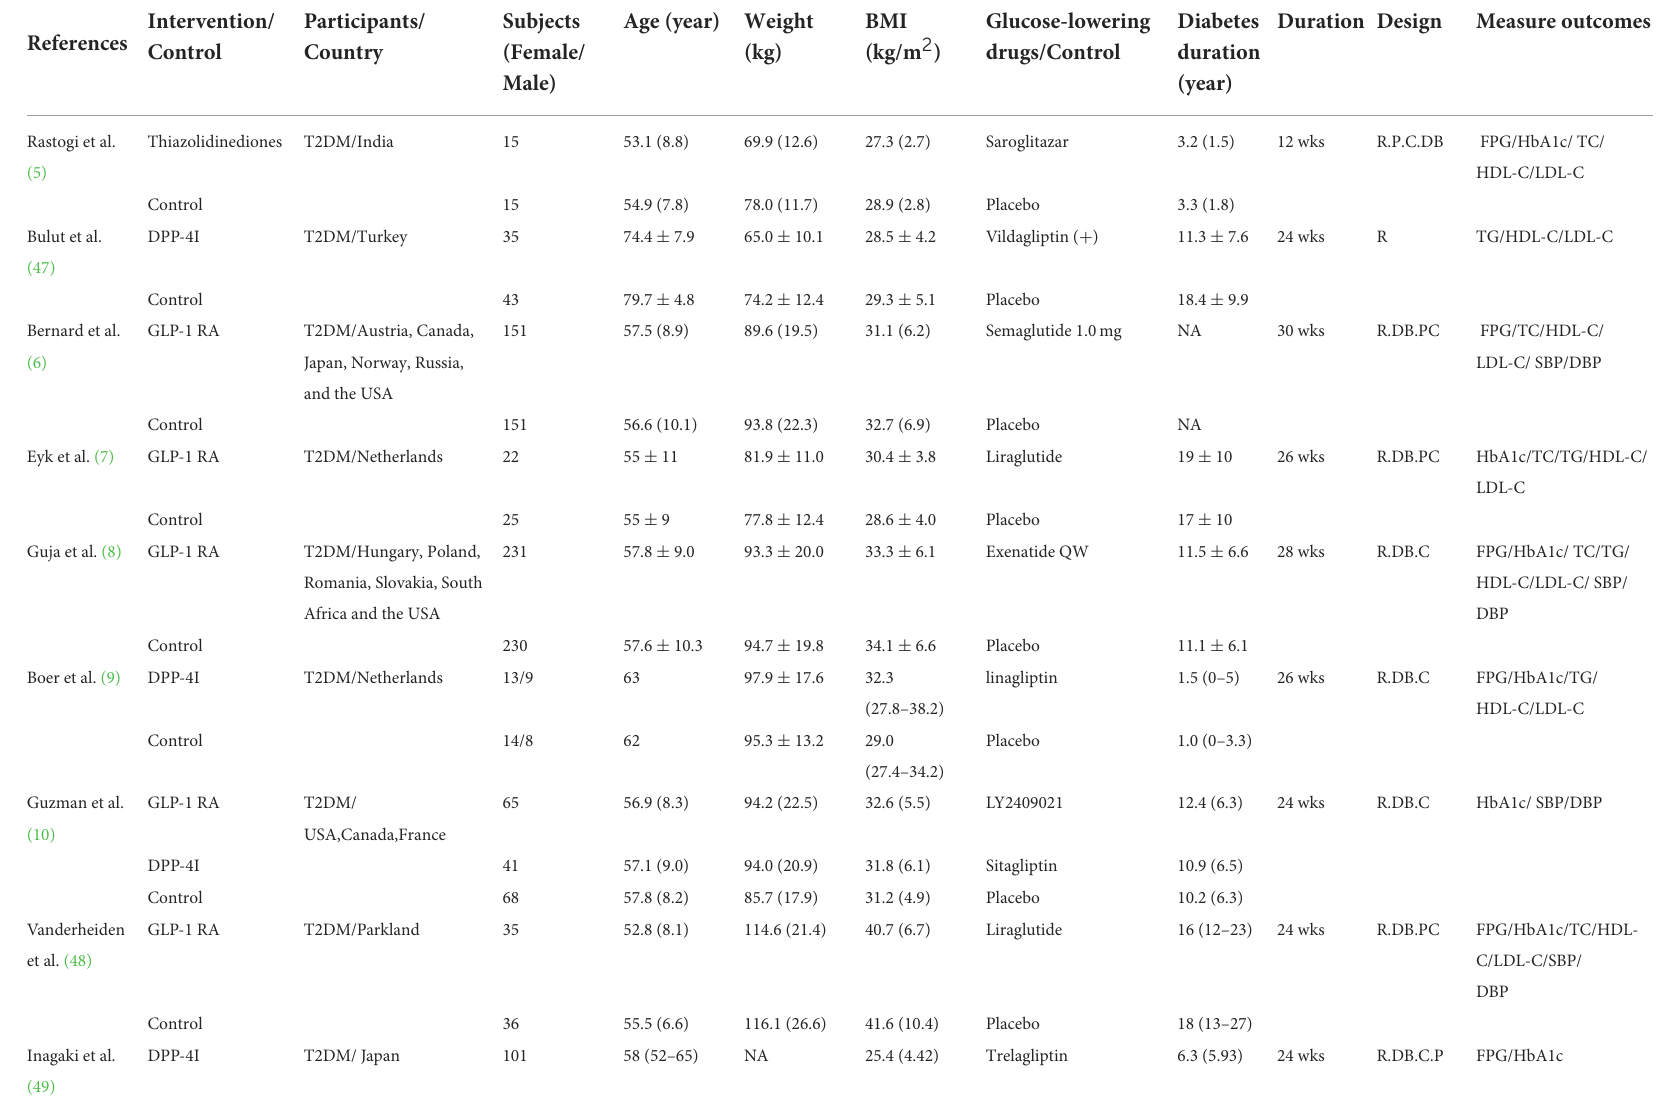
TABLE 2 Characteristics of hypoglycemic drug treatment studies included in this meta-analysis. Intervention/ References